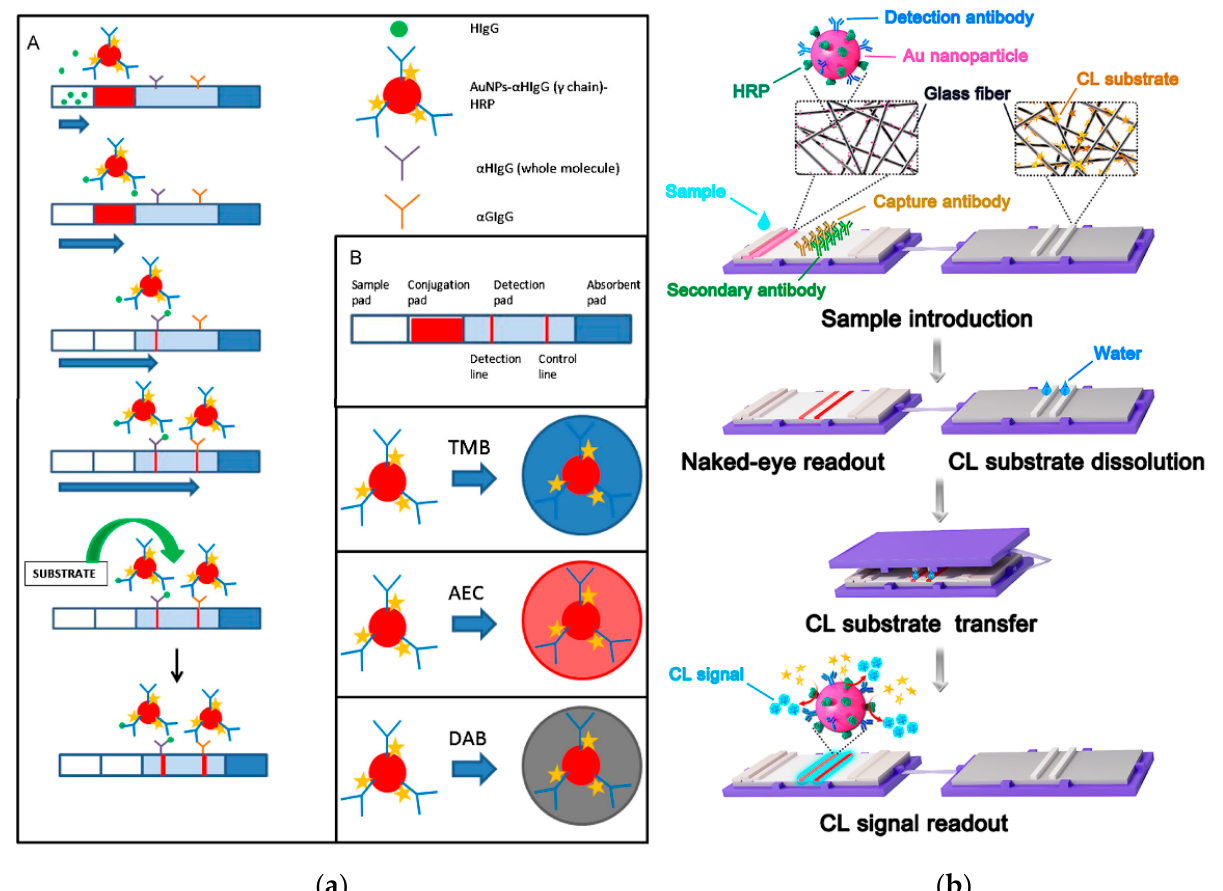
Figure 4. ( a ): ( A ) Scheme of the LFIA for the detection of HIgG. ( B ) Detail of the different parts of a LFIA strip and cartoons representing the AuNP modified with the antibody anti-human IgG γ chain specific HRP modified, and the different colors expected for the different substrates (TMB, AEC and DAB) used. Reprinted from Ref [72], Copyright (2012), with permission from Elsevier. ( b ) Scheme of the CLFAs for the Detection of Targets: Sample is introduced on the sample pad and moves to the absorbent pad. When sample flows through the conjugate pad, the targets are recognized by the detection antibodies on the AuNPs. With sample flowing through the NC membrane, targets and detection antibodies, as well as AuNPs, are immobilized on the NC membrane. After the appearance of the red lines because of the aggregation of AuNPs, the substrate pad containing lyophilized substrate is covered on the LFA strip for the transfer of the CL substrate. Then, the substrate pad is removed, and the CL signal is captured for quantitative detection of targets. Reprinted from Ref [76], Copyright (2018), with permission of the American Chemical Society. Table 1. Comparison of performance of HRP-based LFIAs for the detection of IgG (for reference, conventional AuNP-based LFIAs and ELISAs for IgG are also reported as the first and last table entries, respectively). Technique Detection Principle Tracer Limit of Detection Reference Colorimetric LFIA Visual detection AuNP Measurement of color Colorimetric LFIA intensity with a AuNP portable strip reader HRP with metal enhancer (AuNPs) Colorimetric LFIA Visual detection using TMB